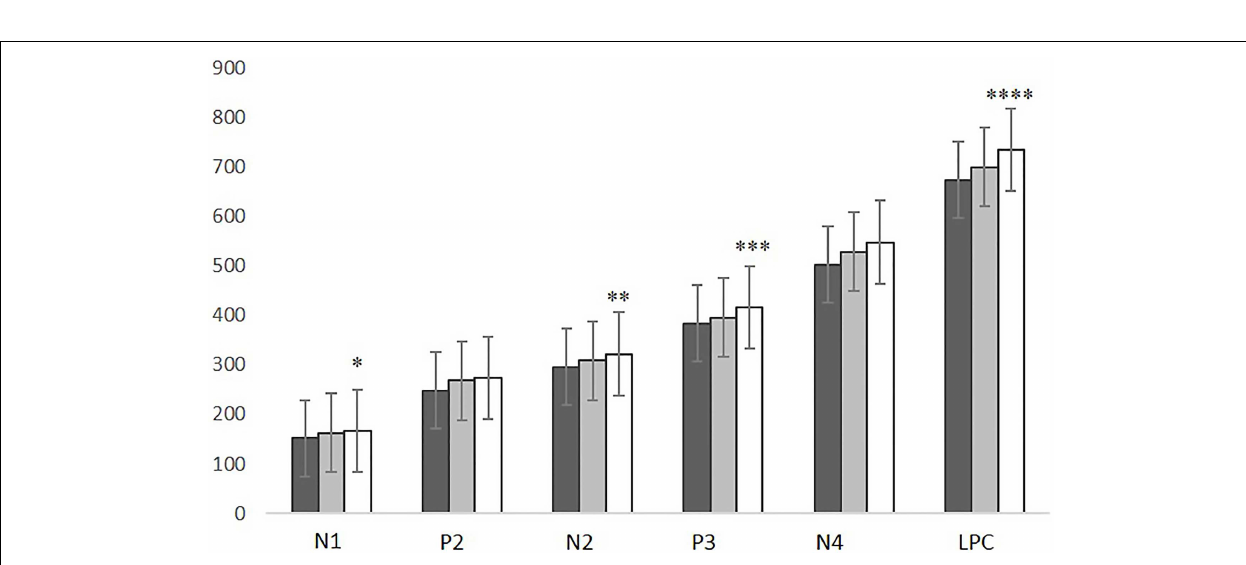
FIGURE 2 | Reaction times in the choice condition, the go/no-go condition and the simple reaction time condition, in CNT subjects (black), PLS patients (gray), andALS patients (white) . *PLS vs. CNT p < 0.001; **PLS vs. ALS p = 0.002. Line bars over each column indicate Standard Error.